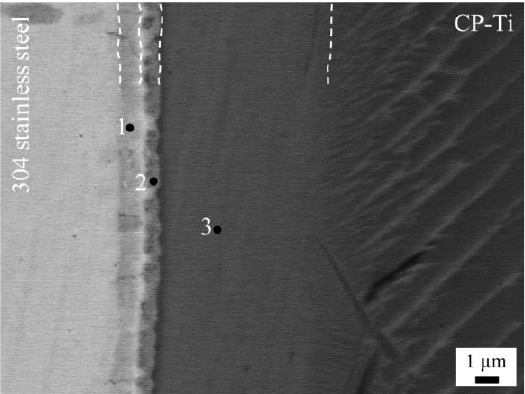
Figure 7. A typical scanning electron microscopy backscattered electron (SEM-BSE) image of the JHDBed 304 stainless steel / CP-Ti joint (axial pressure, bonding time, and bonding temperature of 10 MPa, 25 s, and 1240 ◦ C, respectively).